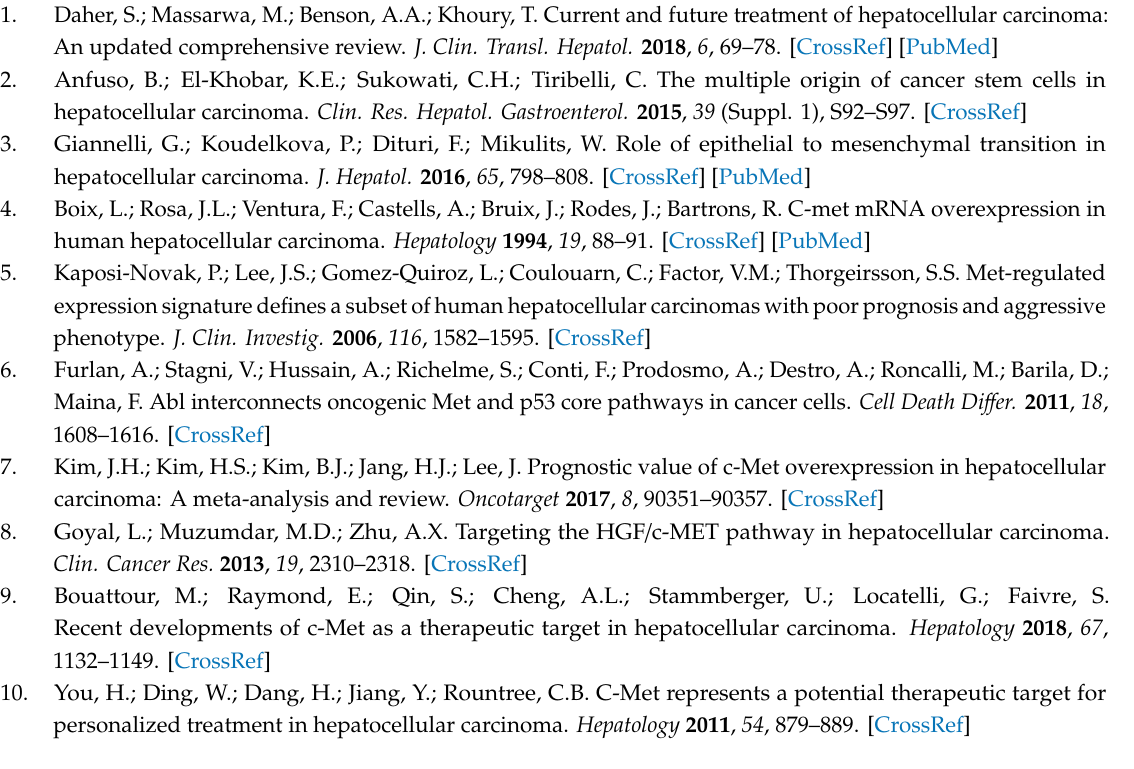
Figure S1: C3G expression is increased in HCC, Figure S2: E ff ect of C3G silencing on in vitro tumorigenic ability, invasive capacity and apoptosis in HCC cells, Figure S3: E ff ect of C3G down-regulation on EMT markers in HCC cells, Figure S3: C3G down-regulation increases apoptosis in human HCC cells, Figure S4: C3G promotes in vivo dissemination of DTCs (Disseminated Tumor Cells) in Bone Marrow, Figure S5: C3G expression increases in lung metastases as compared with primary tumors, Figure S6: C3G interacts with P-MET and Gab1 independently of CrkL, Figure S7: MET is overexpressed in a panel of human hepatocarcinoma cell lines, and Figure S8: C3G knock-down increases p38 MAPK activation, which contributes to C3G knock-down induced migration in Hep3B cells, Figure S9: Uncropped western blots, Supplementary material and methods: Antibodies used for western-blot analysis, primers used for RT-qPCR analysis, β -catenin, apoptotic nuclei and Cleaved Caspase 3 analysis by immunofluorescence, isolation of cells disseminated to bone marrow in xenograft assays, tumor and lung para ffi n embedding, public genomic databases, References [63] are cited in the supplementary